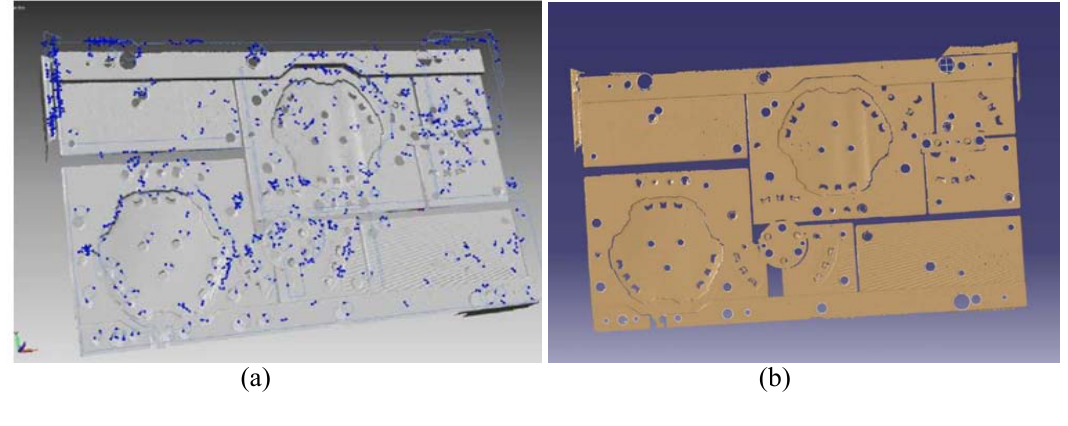
Figure 8 . (a)Using silhouette function for contours, (b) 3D cad model of the